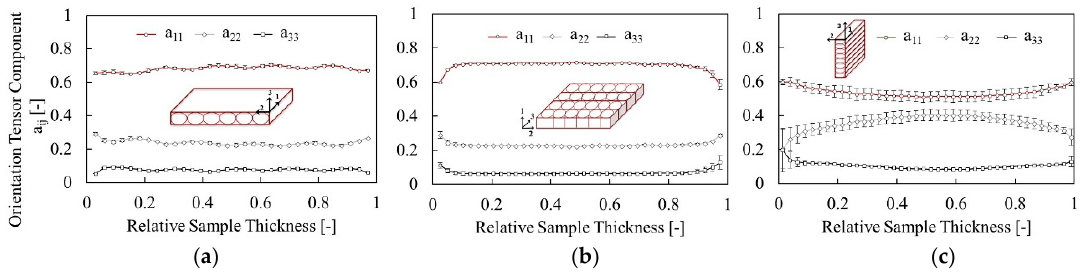
Figure 7. Fiber orientation for printed samples: ( a ) through-plane (TP) sample, ( b ) laminate (LAM) sample, and ( c ) wall sample.